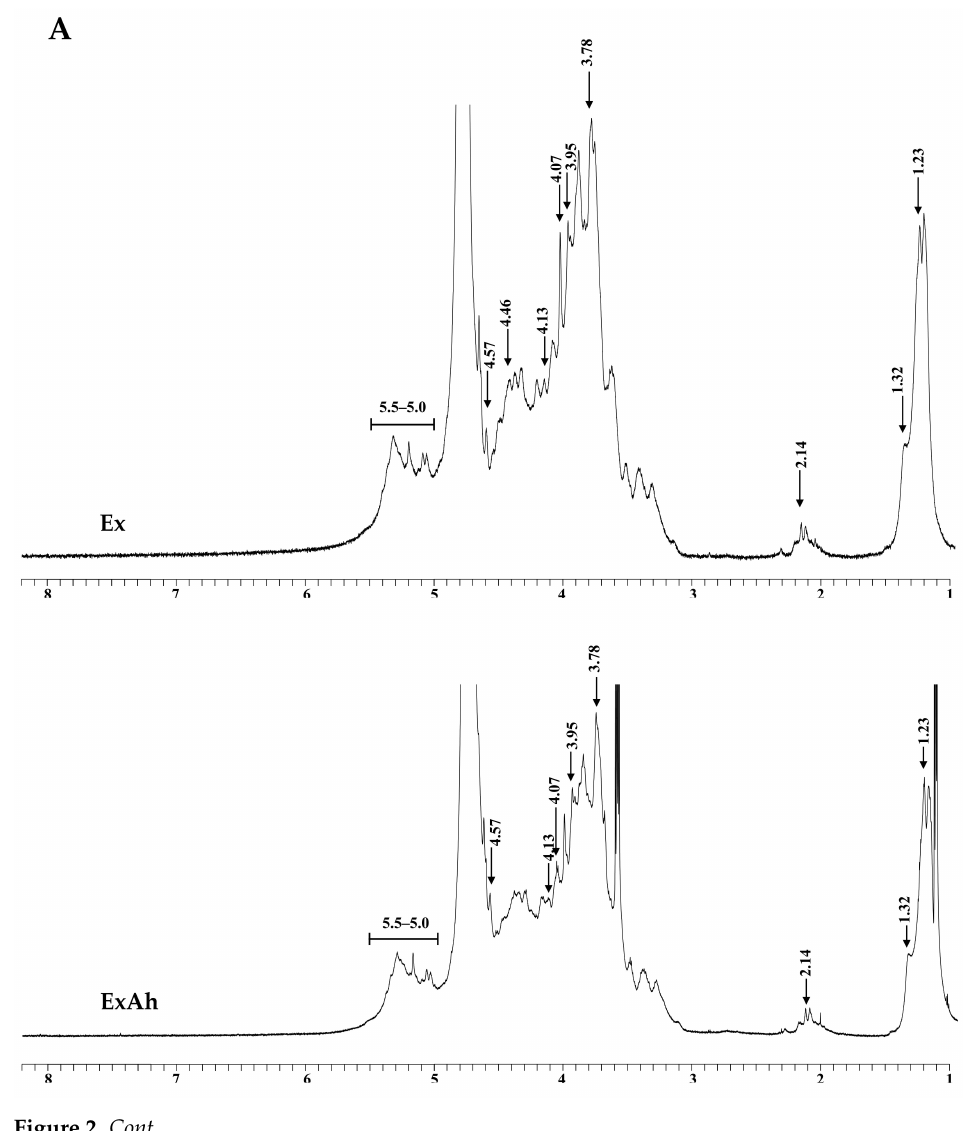
Figure 1. FTIR spectra for Ex, ExAh, and ExHp. Absorption bands at 3401, 2941, 1621, 1421, 1230, 1055, 837, 620, and 580 cm − 1 are indicated.